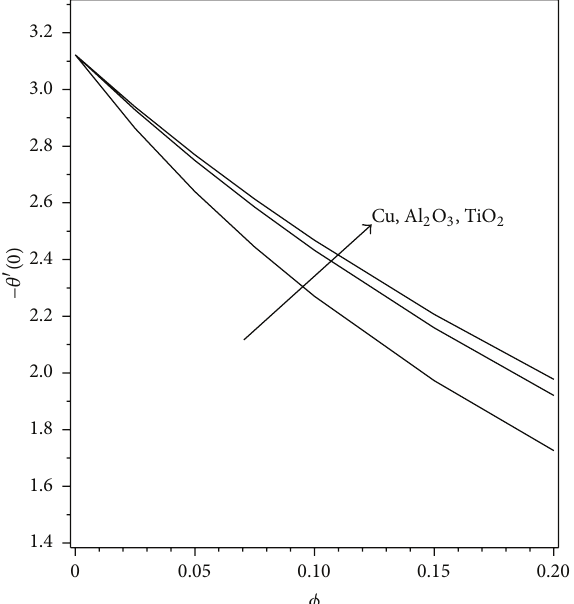
Figure6:Dimensionlessvelocityprofiles 𝑓 󸀠 (𝜂) forCunanoparticles with 𝑚 = 0 and various values of 𝜙 .